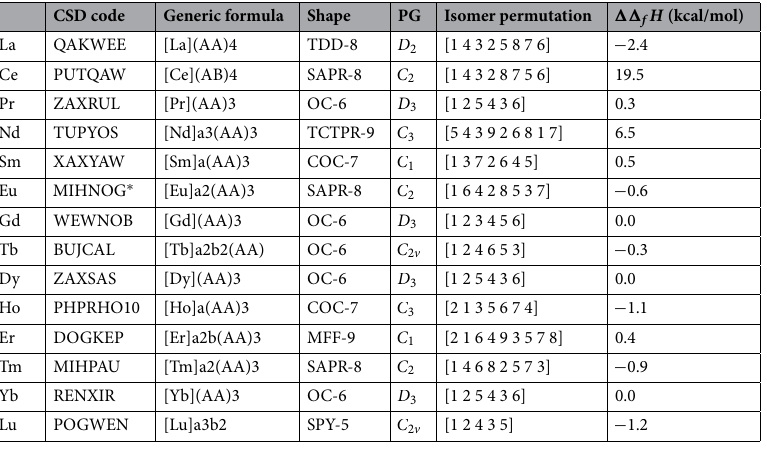
Table 5. Fifteen representative lanthanoid metal complexes are listed, one for each element in the series, along with their generic formula, as well as the point group, PG, and isomer permutation of its coordination polyhedron crystallographic structure. The last column contains (cid:31)(cid:31) f H , the difference in enthalpy of formation between the same compound constructed using the Complex Build algorithm and the crystal structure after both have undergone a geometry optimization by the MOPAC 2016 34 software using the RM1 Hamiltonian 28–32 . When the value of (cid:31)(cid:31) f H is negative, the Complex Build starting structure led to a more stable RM1 optimized geometry. *Crystallographic structure presented one imaginary frequency upon optimization with MOPAC